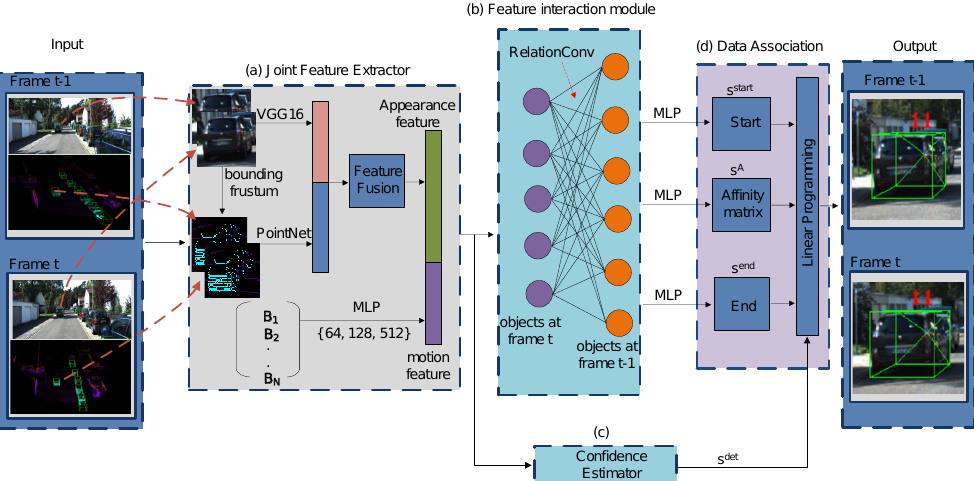
Figure 1. Relation3DMOT architecture. The architecture consists of 4 main parts. The Joint Feature extractor ( a ) takes the objects with 2D/3D bounding boxes as input, and then applies 2D feature extractor VGG-16 and 3D feature extractor PointNet on the cropped image and point cloud, respec- tively, to capture 2D/3D features, followed by a feature fusion module to obtain the appearance feature for each detected object. The motion feature is extracted by applying the 2D bounding boxes on a proposed MLP network. Note that the numbers in the brace indicate the number of the learning convolutional parameters for the MLP network. Finally, we achieve fusion by concatenating the appearance feature and the motion feature for each object. { B 1 , B 2 , . . . B N } denotes a list of the 2D bounding boxes information. In the Feature Interaction module ( b ), we propose the novel RelationConv operation to build a feature interaction module for discriminative feature extraction. The Confidence Estimator ( c ) predicts whether the detected objects are true positive. In the Data Association mod- ule ( d ), we finally learn an affinity matrix and predict several binary scores to optimize the data association